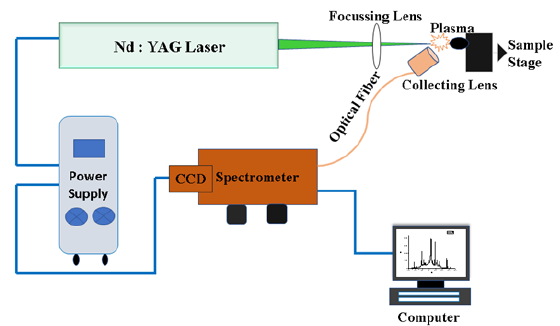
Figure 1. Schematic diagram of the experimental setup for